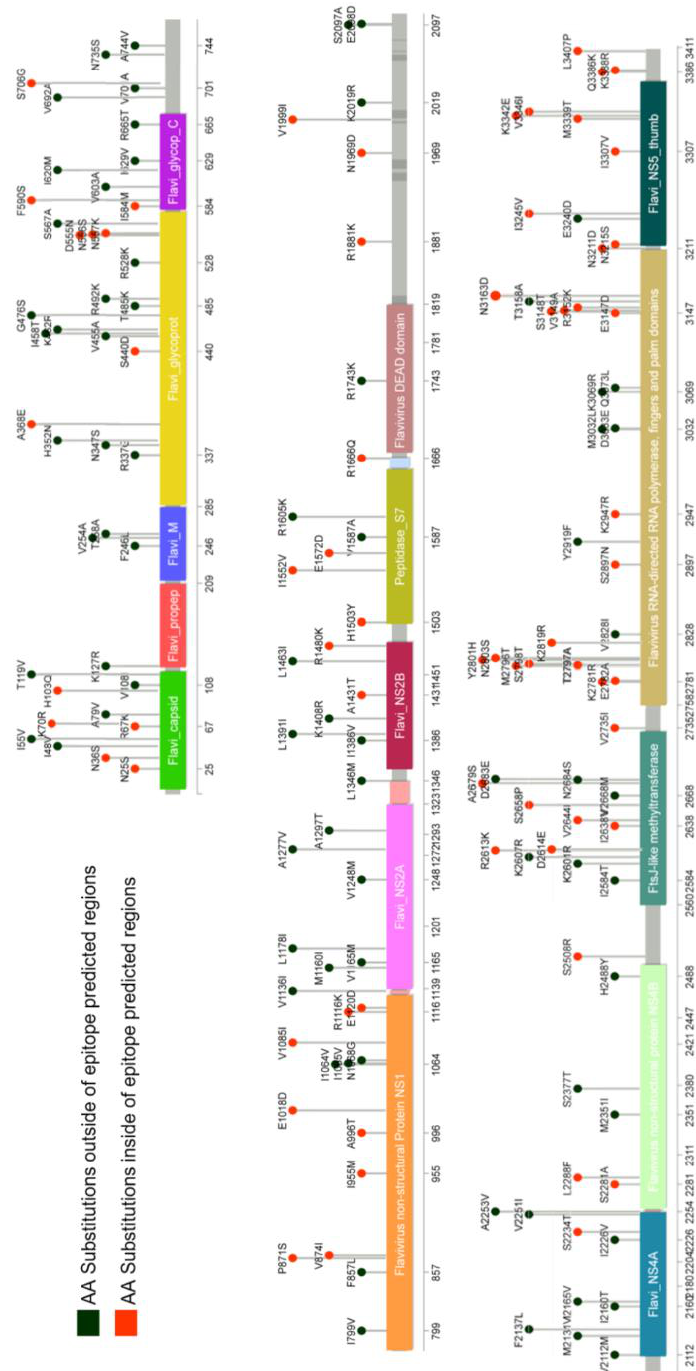
Figure 1. Distribution of amino acid substitutions in the YFV polyprotein. Using the protein sequence of the 17DD vaccine strain as a reference, differences in the amino acid sequences related to the 2017 isolate ES-505 were identified. The 144 substitutions identified are distributed throughout the virus polyprotein